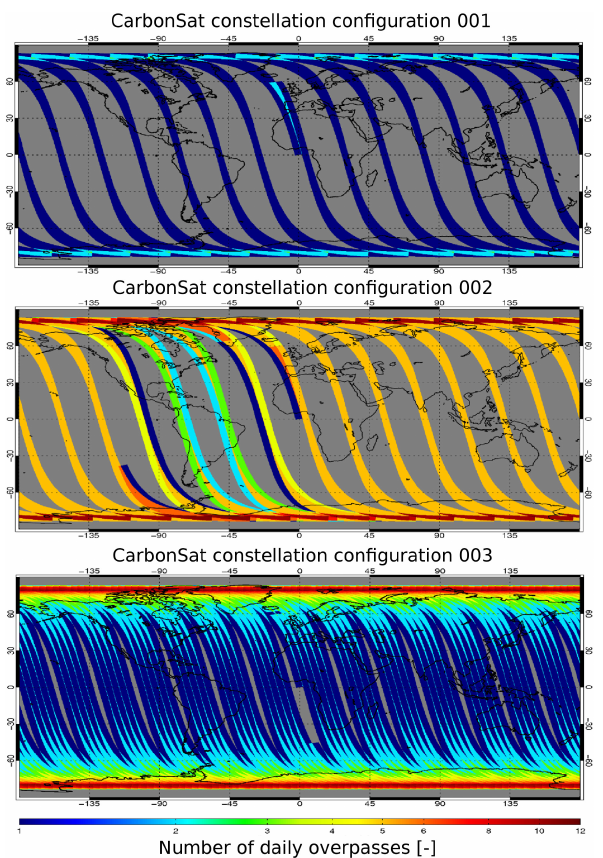
Fig. 3. Top panel: one-day coverage for one-CarbonSat (configu- ration 001). Middle panel: one-day coverage for a 5-satellite con- stellation with each satellite passing over the target on the same day every 2h (configuration 002). Bottom panel: one-day coverage for a 5-satellite constellation all with a local time at ascenting node of 13:30 and one day apart (configuration 003). The assumed swath width of CarbonSat is 500km.